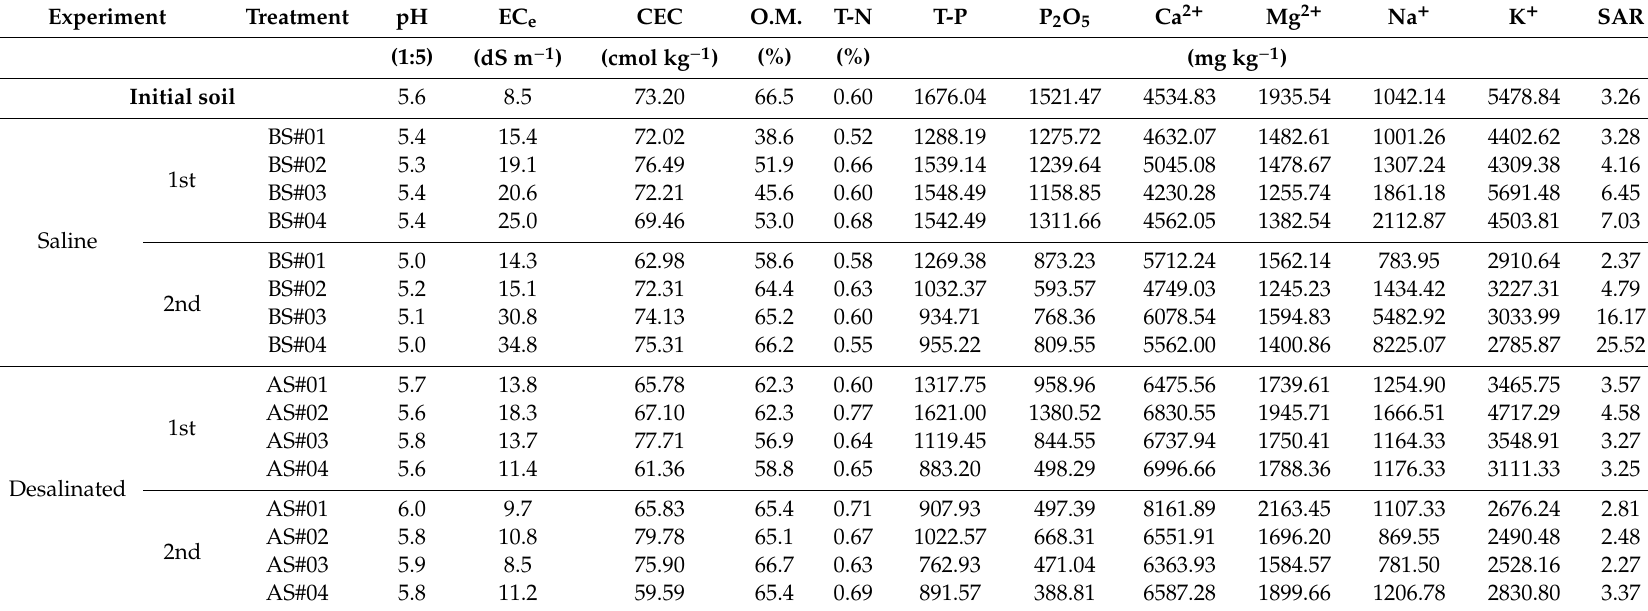
Table 3. Chemical properties of the sampled soils from each